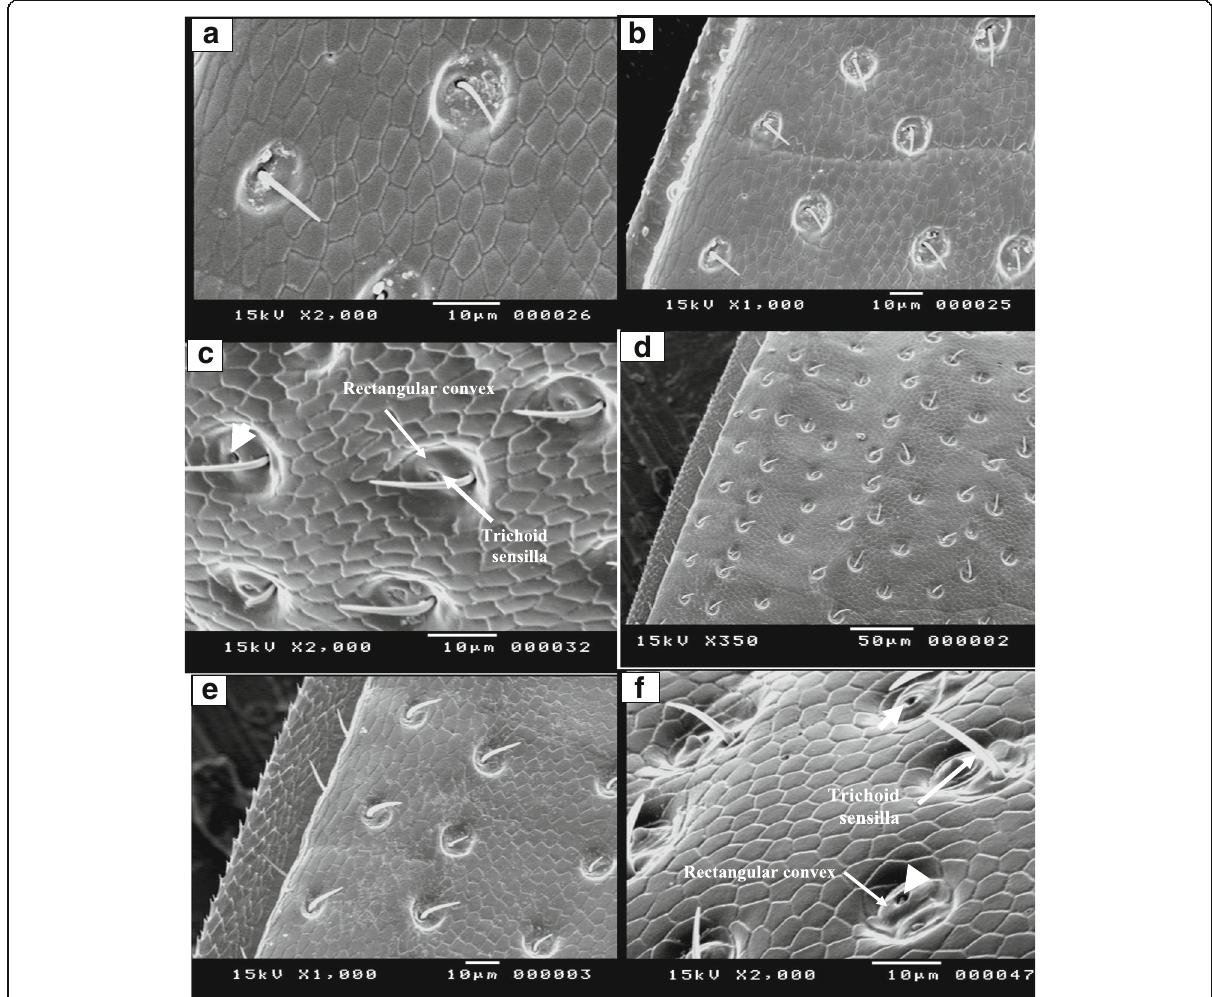
Fig. 2 Scanning electron microscope (SEM) images of elytral microstructure, dorsal surface of a – c Tribolium castanaeum and d – f Tribolium confusum showing the opening of gland (head arrow) and trichoid